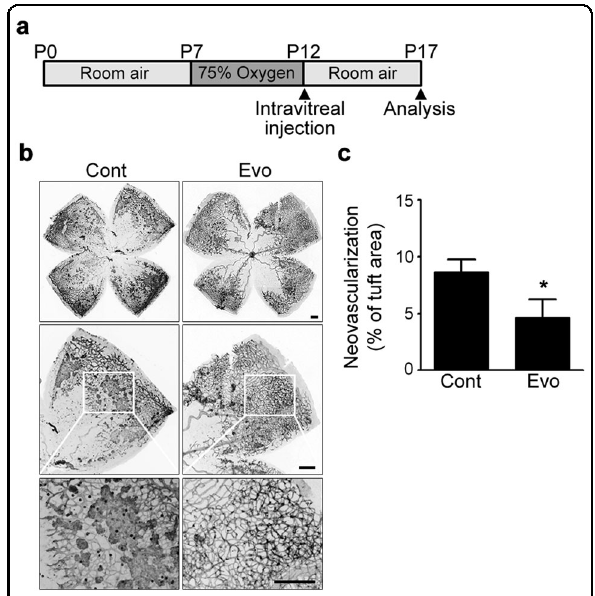
Fig. 1 Intravitreal administration of evogliptin alleviated pathological retinal NV in mice with OIR. a Schematic illustration of OIR experiments. On P12, mice received a single intravitreal injection of evogliptin (Evo; 10 μ g in 1 μ L of DMSO) or DMSO (1 μ L; contralateral control (Cont)). Five days later (on P17), the eyes were harvested for further analysis. b Representative images of whole-mounted retinas of mice with OIR. The retinal vasculature was visualized by staining with IB4 (black). High-magni fi cation views of the boxed areas are shown at the bottom. Scale bars = 100 μ m. c Retinal NV in mice with OIR was quanti fi ed as a percentage of the number of pixels in the neovascular tuft compared to the total number of pixels in the entire retina. Data are presented as the mean ± SEM (unpaired Student ’ s t test, * p < 0.05, n > 11